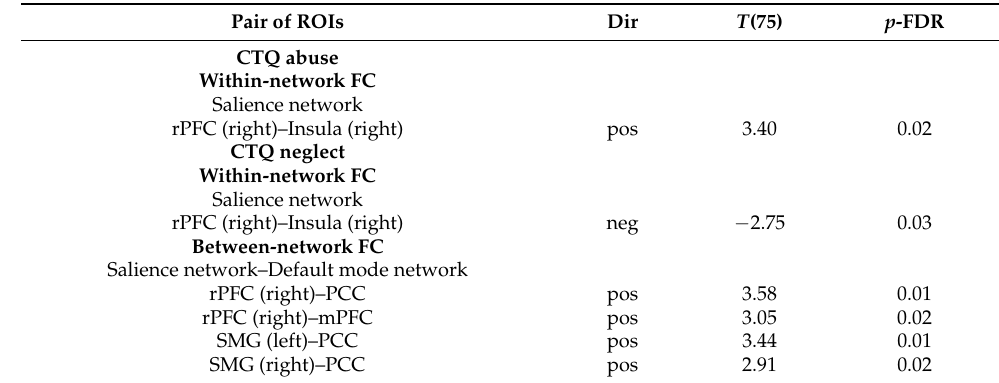
Table 3. Significant associations between CTQ abuse and ROI-to-ROI FC, as well as CTQ neglect and ROI-to-ROI-FC, sorted by within- and between-network FC. Pair of ROIs